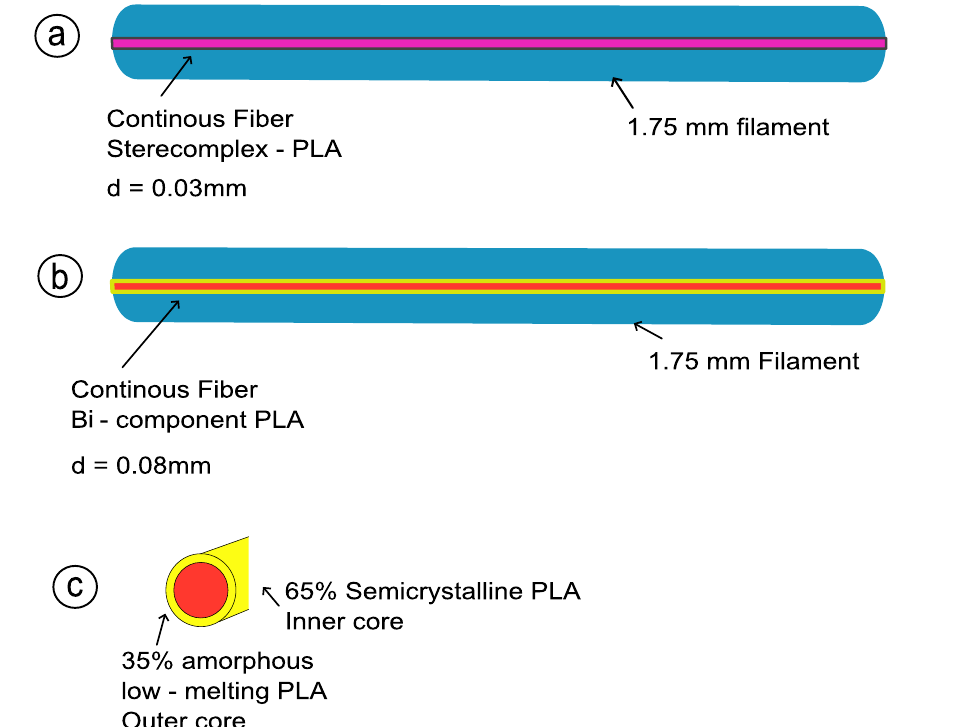
Figure 4. ( a ) visualisation showing core PLA and matrix PLA for the Sc-PLA PLA composite, ( b ) vi- sualisation showing core bi-co fibre in the PLA matrix for the second self-reinforced composite, and ( c ) cross section of the bi-co fibre showing the inner core and the outer sheath material